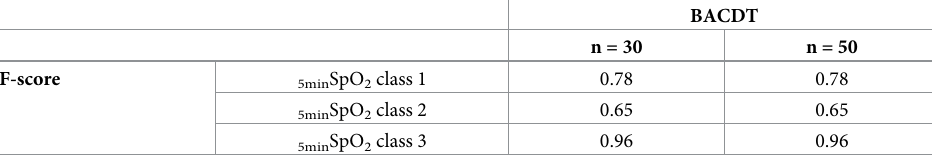
Table 5. Absence of impact on performance of the number of complex trees for bootstrap aggregation of complex decision trees (BACDT). Example of the performance assessed by the F score on the balanced test dataset 3 (see Table